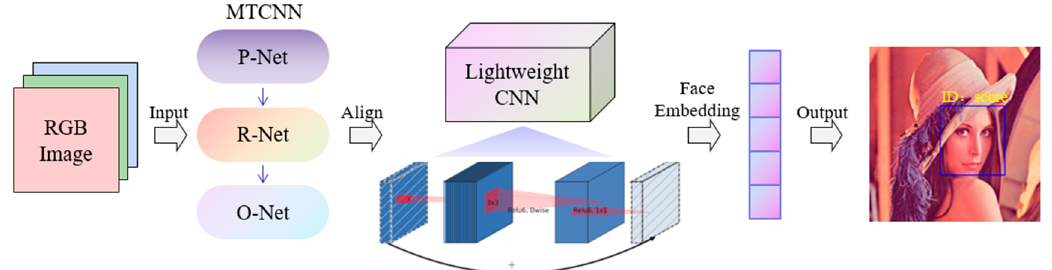
Figure 2. Face recognition based on a lightweight CNN.